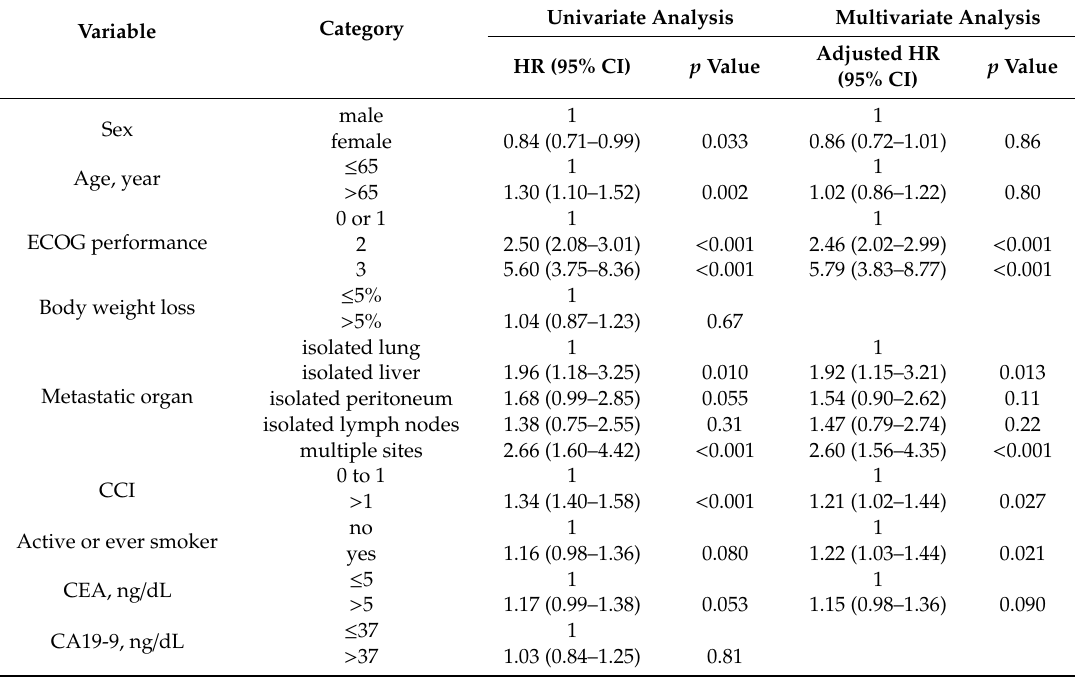
Table 3. Univariate and multivariate analysis for overall survival.